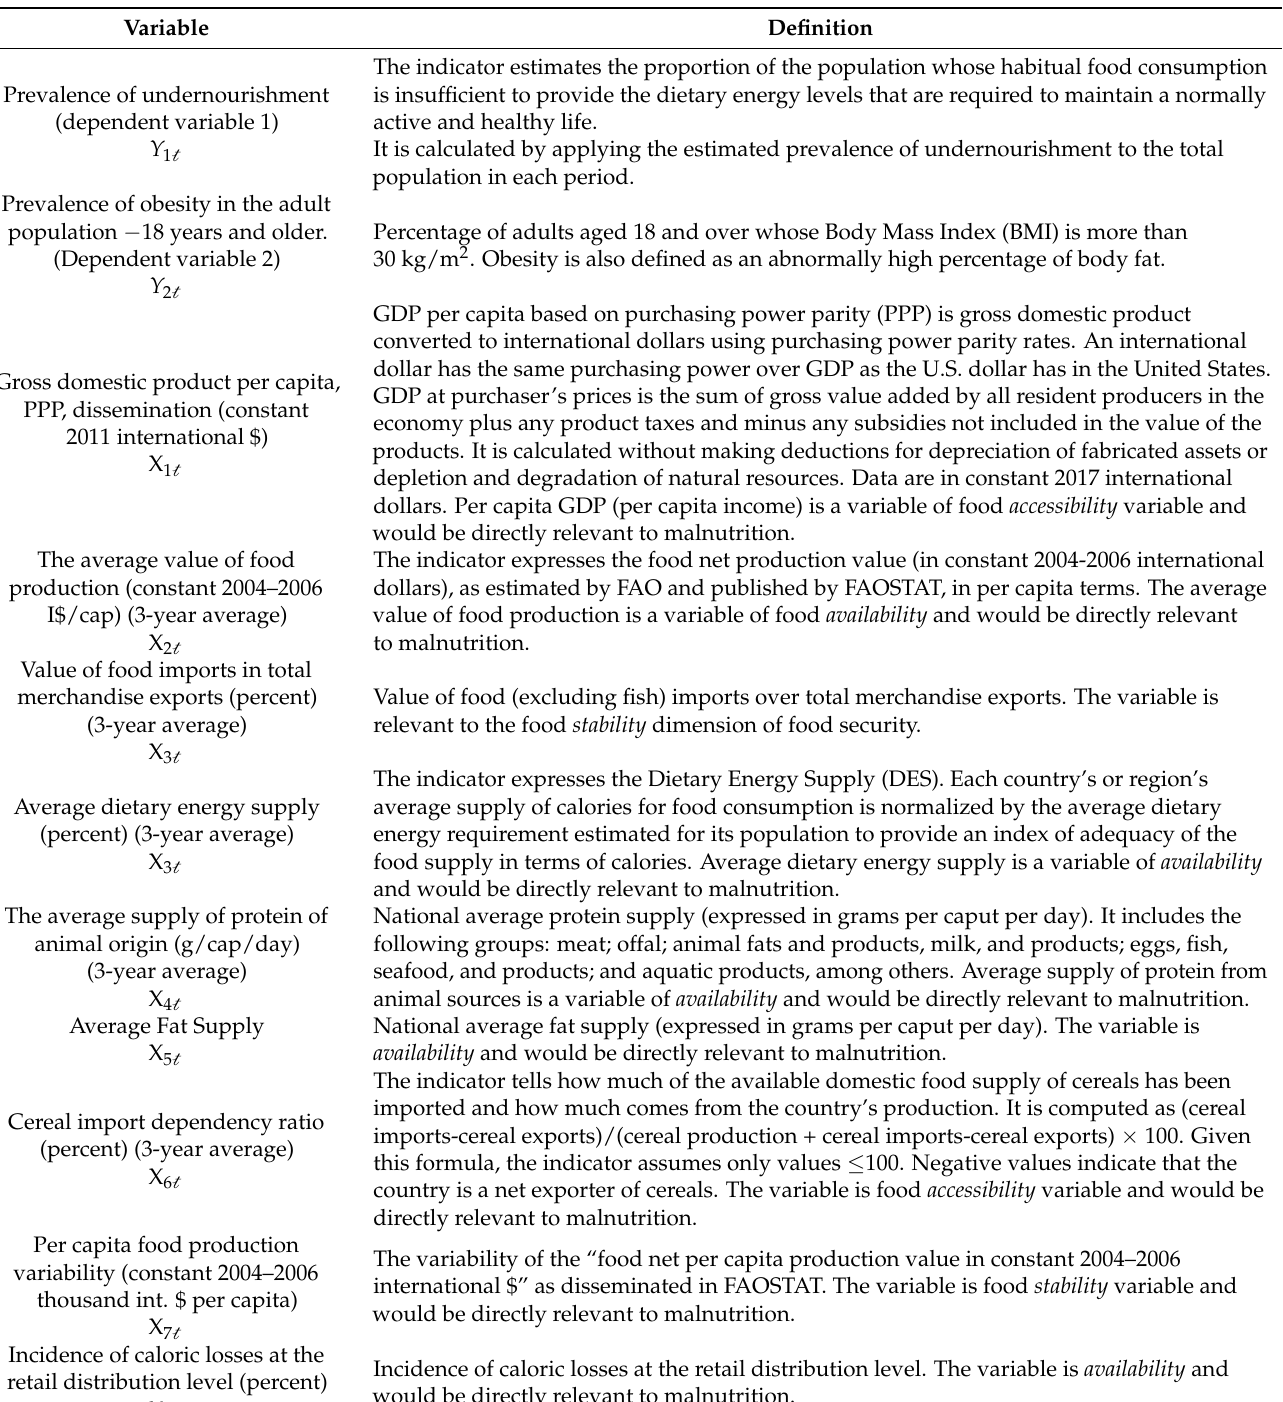
Table 2. Definitions of the dependent and explanatory variables used in the